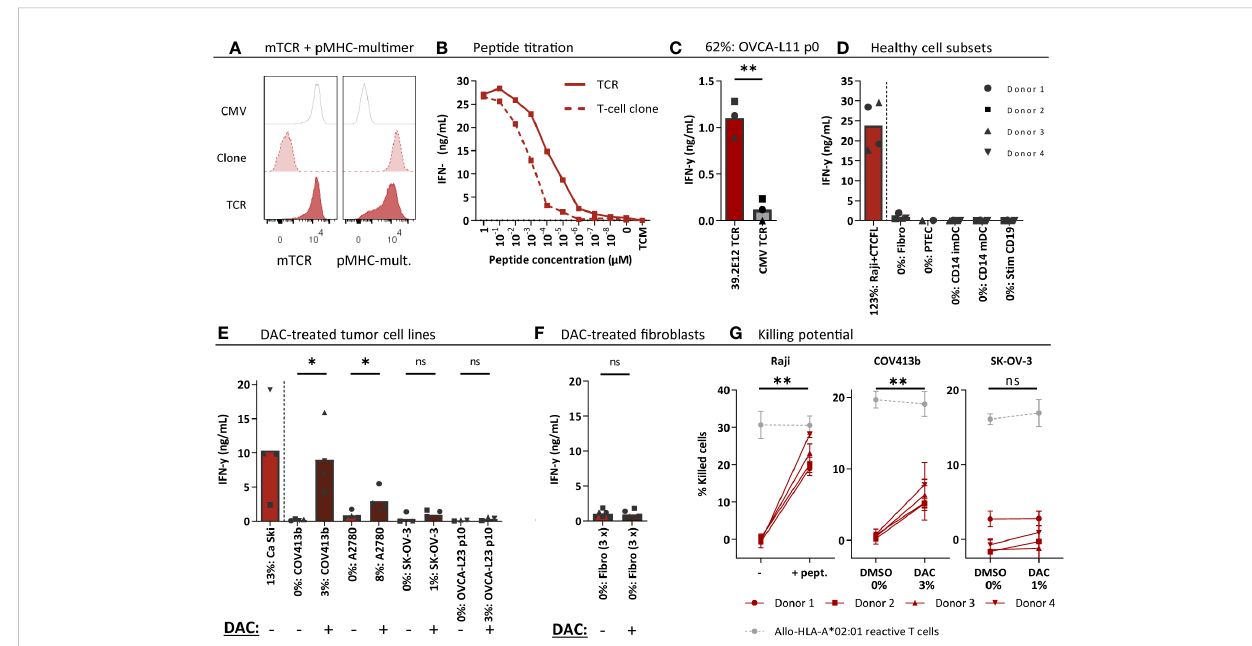
FIGURE 6 CTCFL TCR-T cells recognize and kill (DAC-treated) CTCFL positive OVCA cells. CD8+ cells of four different donors were retrovirally transduced to express the 39.2E12 CTCFL/KLH/A2 TCR and puri fi ed. (A) Representative fl ow cytometry plots of puri fi ed CMV and CTCFL TCR-T cells, and the parental CTCFL T-cell clone stained with murine TCR (mTCR) and the CTCFL-speci fi c pMHC-mult. (B) IFN- g production (ng/mL) of the TCR-T cells and parental T-cell clone cocultured overnight with Raji cells transduced with HLA-A*02:01 and loaded with titrated peptide concentrations (E:T = 1:6). (C – F) IFN- g production of TCR-T cells cocultured with (C) single viable cells of primary patient-derived sample OVCA-L11 passage 0 (E:T 1:6), (D) healthy cell subsets of multiple donors (E:T = 1:4 for fi broblasts, PTECs and CD14+, and 1:6 for CD19+), (E) 7 days 1 µM DAC or DMSO treated tumor cells (E:T = 1:6), and (F) 7 days 1 µM DAC or DMSO treated fi broblasts. Bars represent mean and symbols depict averaged duplicate values from three or four different donors tested in two independent experiments. (G) Cytotoxic capacity of CTCFL TCR-T cells in a 6-hour 51 Cr-release assay against Raji cells loaded with the KLH peptide, and COV413b and SK-OV-3 treated with 7 days 1 µM DAC or DMSO. Mean and SD depict technical triplicates from four different donors tested in two independent experiments, at E:T ratio 10:1. Cytotoxic capacity of an allo-HLA-A*02:01 reactive T-cell clone recognizing HKG USP11 is shown for the different conditions (41). (B – G) All target cells express HLA-A*02:01, either wildtype or the HLA allele was introduced by transduction (Raji, SK-OV-3, A2780). Percentage relative CTCFL (TvX) expression is depicted, as determined by qPCR. (D) IFN- g production of CTCFL TCR- and CMV TCR-T cells compared using a paired t-test (two-sided). (E – G) IFN- g production and cytotoxicity of CTCFL TCR-T cells cocultured with DMSO and DAC-treated cells, or Raji cells loaded with and without peptide, compared using a paired t-test (two-sided). (ns, not signi fi cant; DAC, 5-aza-2 ′ -deoxycytidine; imDCs and mDCs, immature and mature dendritic cells; pMHC-mult, peptide MHC-multimers; PTECs, proximal tubular epithelial cells; OVCA, primary ovarian carcinoma sample). Meaning of the * are listed in the M&M. Signi fi cance levels are indicated as p <.05 *, p <.01 **. ns, not signi fi